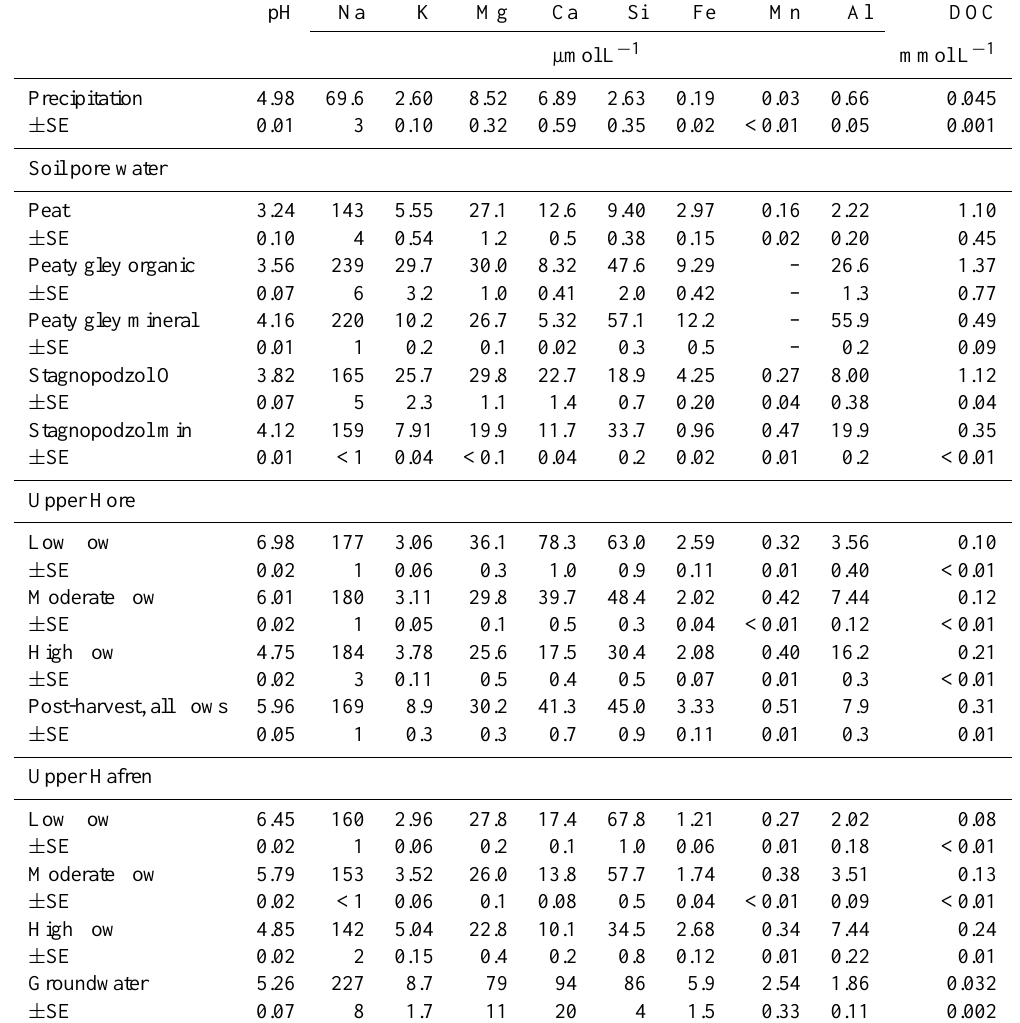
Table 3. Solute concentrations ( ± standard error) averaged over all available data collected from the Upper Hore (pre-harvest: 1983–2005; post-harvest: 2005–2010) and Upper Hafren (1990–2010) catchments in the Plynlimon forest in Wales,